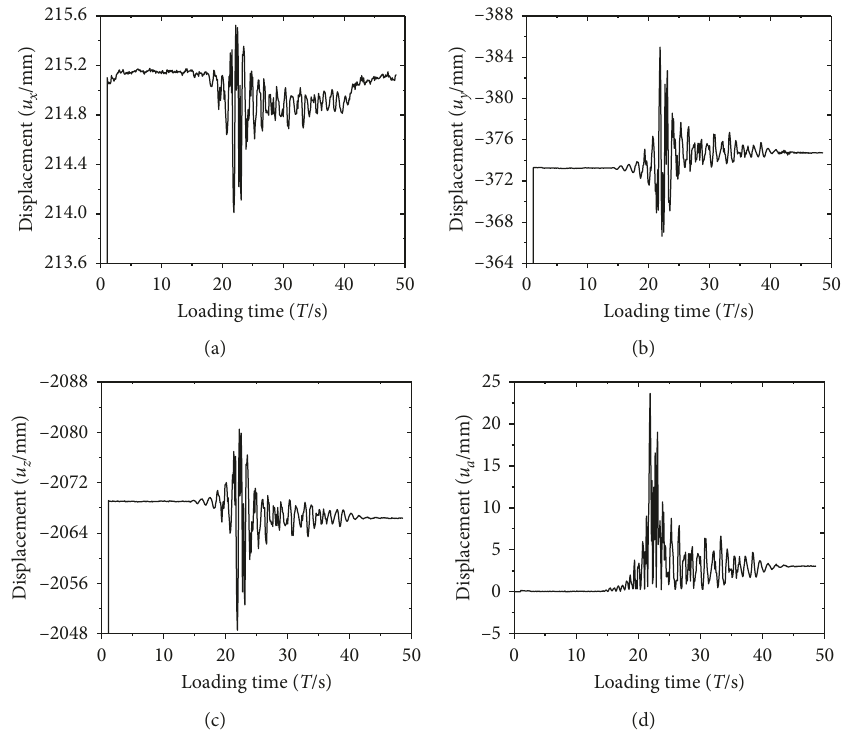
Figure 13: Variation of displacement with loading